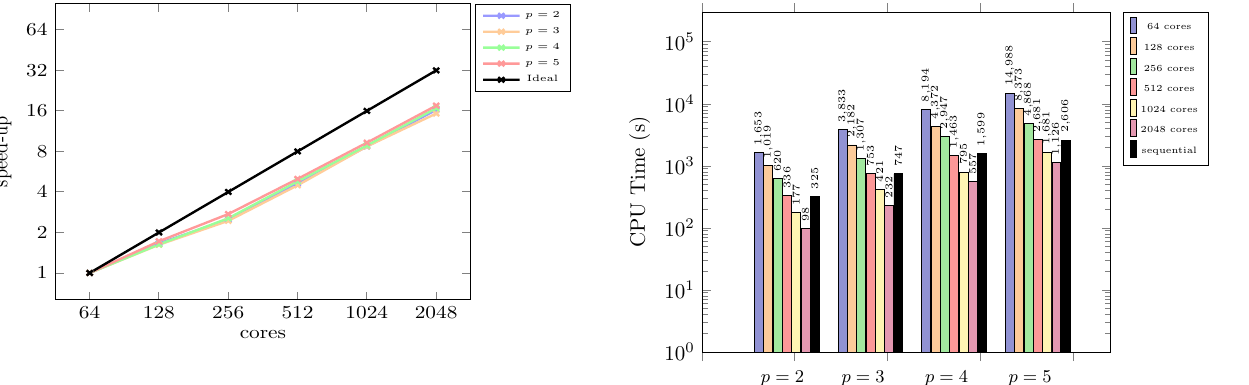
Fig. 9 Speed-up with MGRIT using V-cycles and backward Euler on the unit square. Here p -multigrid is used for all spatial solves within MGRIT Fig. 10 Strong scalability study for MGRIT using V-cycles and back- ward Euler on the unit cube. Here p -multigrid is used for all spatial solves within MGRIT